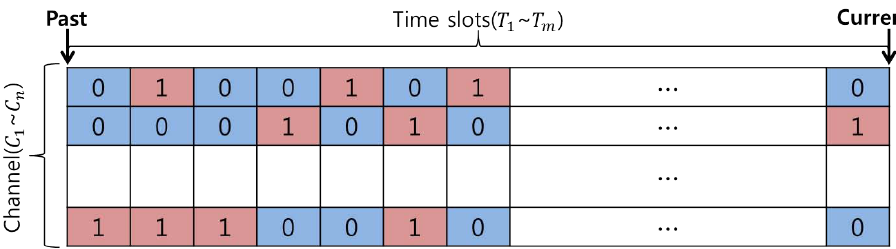
Figure 2. Incumbent user activity modeling based on an ON/OFF